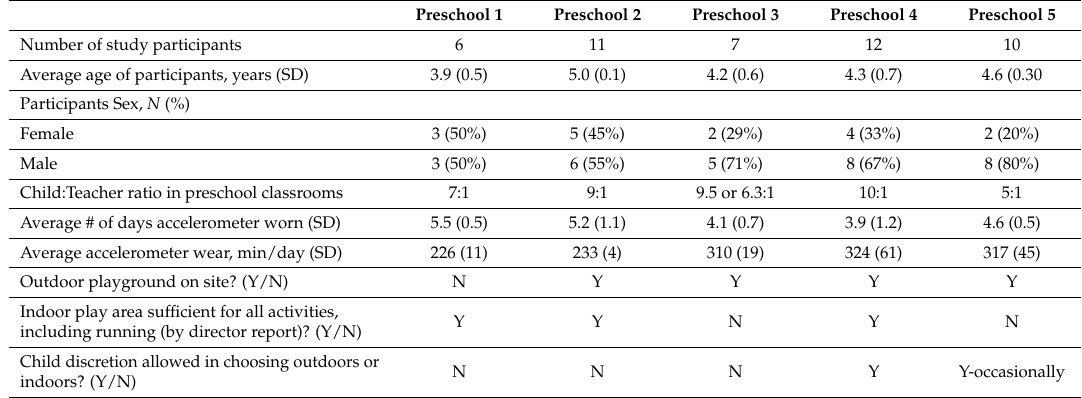
Table 1. Descriptive characteristics of children and preschool programs.